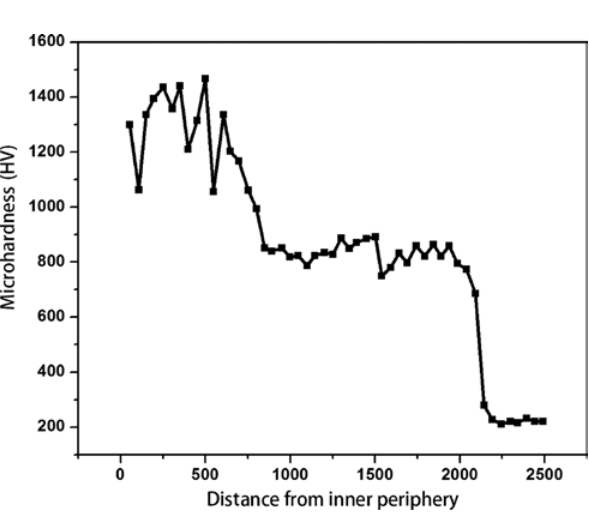
Figure 19: Apparatus of PTAC.